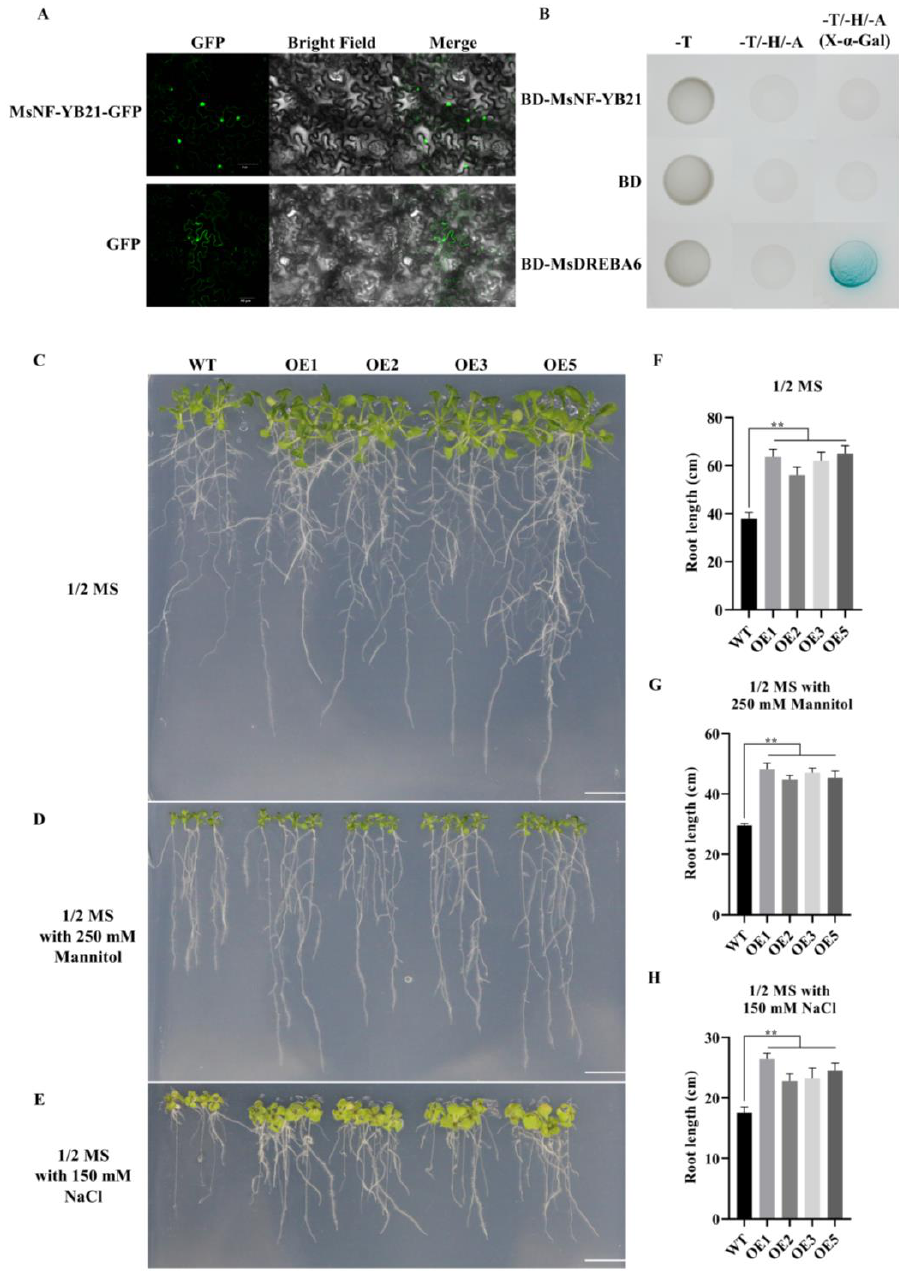
Figure 4. Characteristics of MsNF-YB21 and plant growth features of MsNF-YB21 overexpression lines under normal and stress conditions. ( A ) Subcellular localization of transiently expressed 35S::GFP and 35S::MdNF-YB21::GFP in N. benthamiana leaves. The GFP (green fluorescent protein) signal was observed by fluorescence microscopy 48 h later. Scale bars = 50 μm. ( B ) Transcription activation activity of MsNF-YB21 in yeast cells. MsDREBA6 and BD (binding domain) were used as positive and negative controls, respectively. Seven day old WT (wild type) and OE ( MsNF-YB21 overexpression) seedlings were transferred to 1/2 Murashige and Skoog (MS) medium, supplemented with 250 mM mannitol ( D ) or 150 mM NaCl ( E ), while standard 1/2 MS was regarded as the control ( C ). Scale bars = 1.0 cm. The primary root length of all lines under different growth conditions was recorded in ( F – H ). Values are the means ± SE (standard error) from three biological replicates. Significant differences of each root length were assessed using Student’s t -test in comparison to WT. (Double asterisks denote p < 0.01).